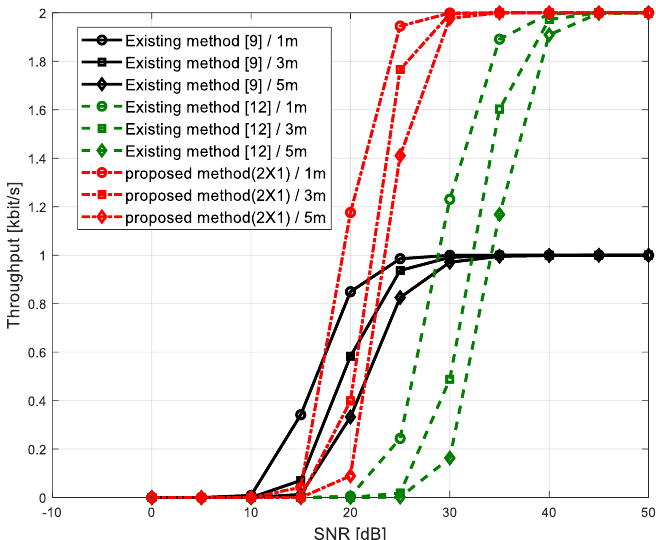
Figure 5. Throughput for existing and the proposed backscatter method.